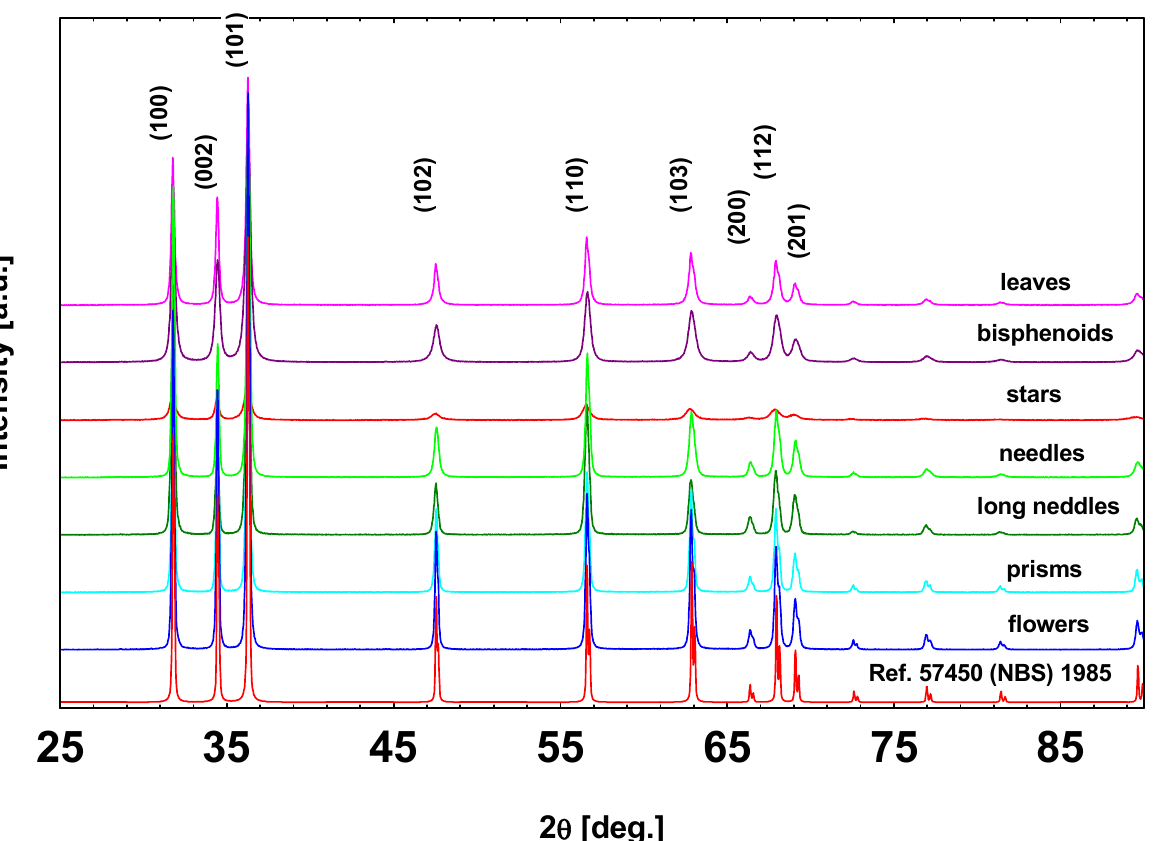
Figure 5. XRD patterns of the ZnO morphologies compared with that of reference. Table 1. Crystalline phase, the unit cell parameters values: a, c, and volume, Bragg R factor, and crystallite size for all ZnO morphologies. In parentheses, the estimated standard deviations are referred to the last digit. Sample